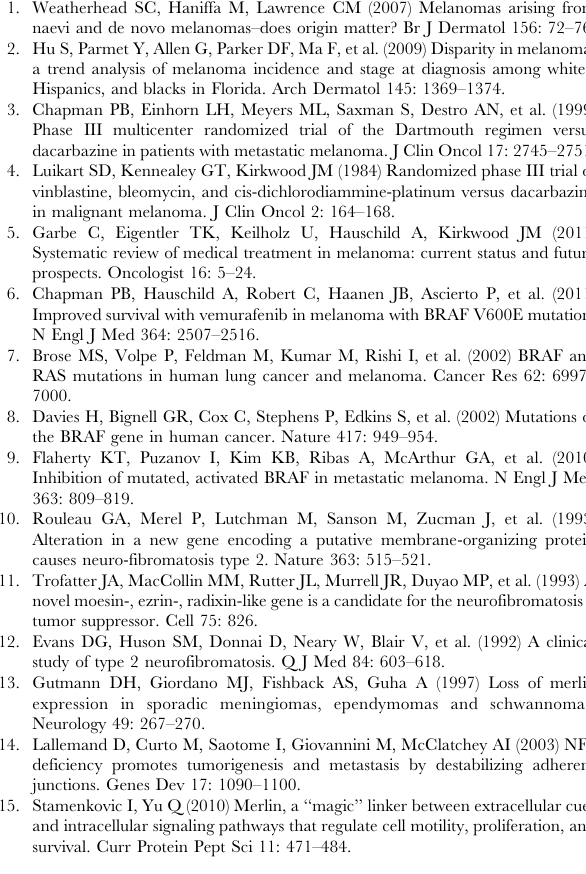
(TIF) Figure S4 Increasing FBS concentration in cell culture media does not affect endogenous merlin protein levels. Western blot analysis of endogenous merlin expression in WM1552C human melanoma cells grown in recommended MCDB media supplemented with 2% or 10% FBS, or in RPMI media with 10% FBS for 72 h. 50 m g of protein was loaded in each lane and actin was used as a loading control (TIF) Table S1 Merlin knockdown confers tumorigenicity to M19-MEL human melanoma cells. Table shows the tumor incidences in Rag1 mice sixty days post injection of 5 6 10 6 of M19-Mel cells with or without merlin knockdown.